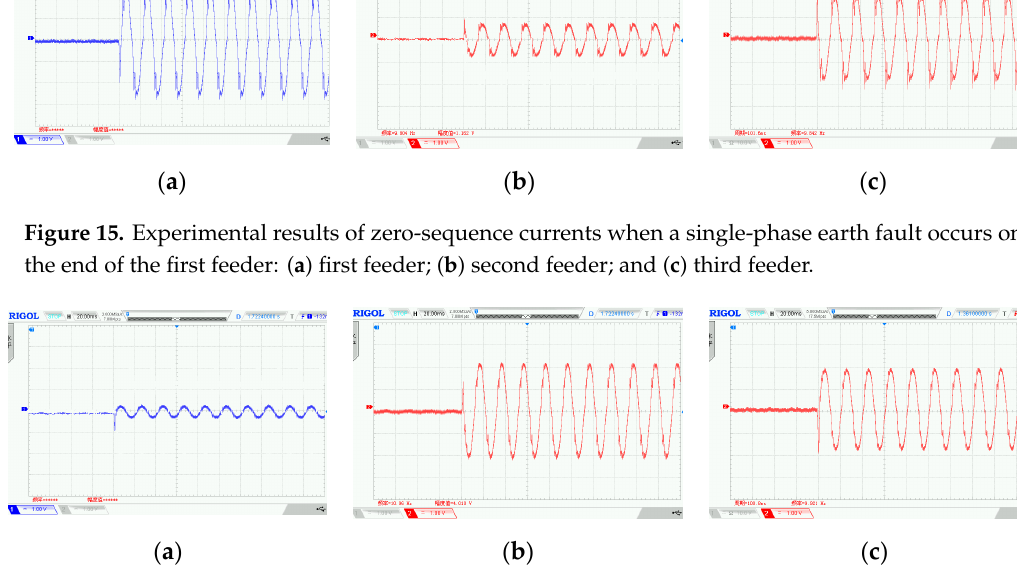
Figure 16. Experimental results of zero-sequence currents when a single-phase earth fault occurs on the middle of the second feeder: ( a ) first feeder; ( b ) second feeder; and ( c ) third feeder.